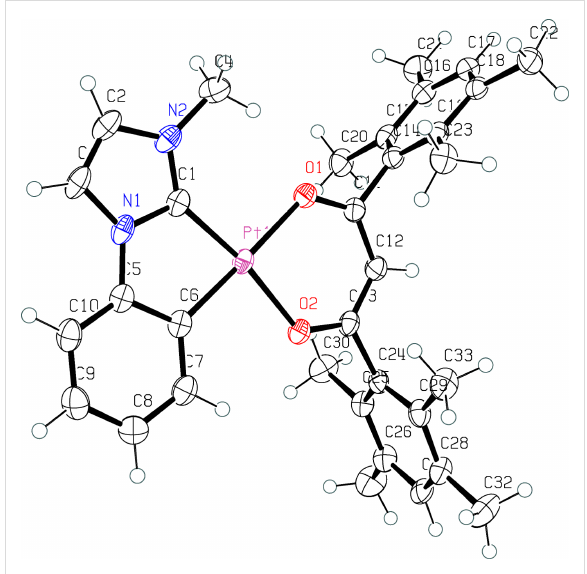
Figure 1: ORTEP representation of 3 . Thermal ellipsoids are drawn at the 50% probability level. Selected bond lengths (Å) and angles (deg): C(1)–Pt(1), 1.950(3); C(6)–Pt(1), 1.988(3); O(1)–Pt(1), 2.089(3); O(2)–Pt(1), 2.047(2); N(1)–C(1), 1.361(4); N(2)–C(1), 1.347(4); C(1)–Pt(1)–C(6), 80.17(13); O(1)–Pt(1)–O(2), 90.51(9); N(1)–C(1)–N(2), 104.8(3); O(1)–Pt(1)–C(1)–N(2), − 2.7(4);